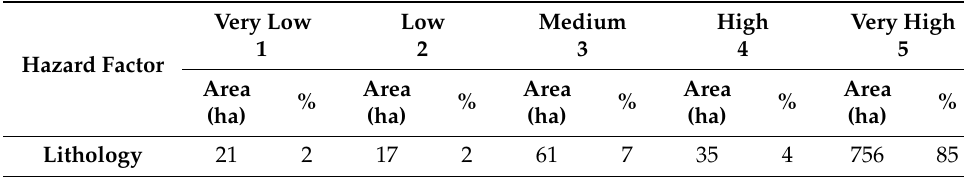
Table 21. Areas and percentages of the study area classified as each class of the lithology hazard factor.